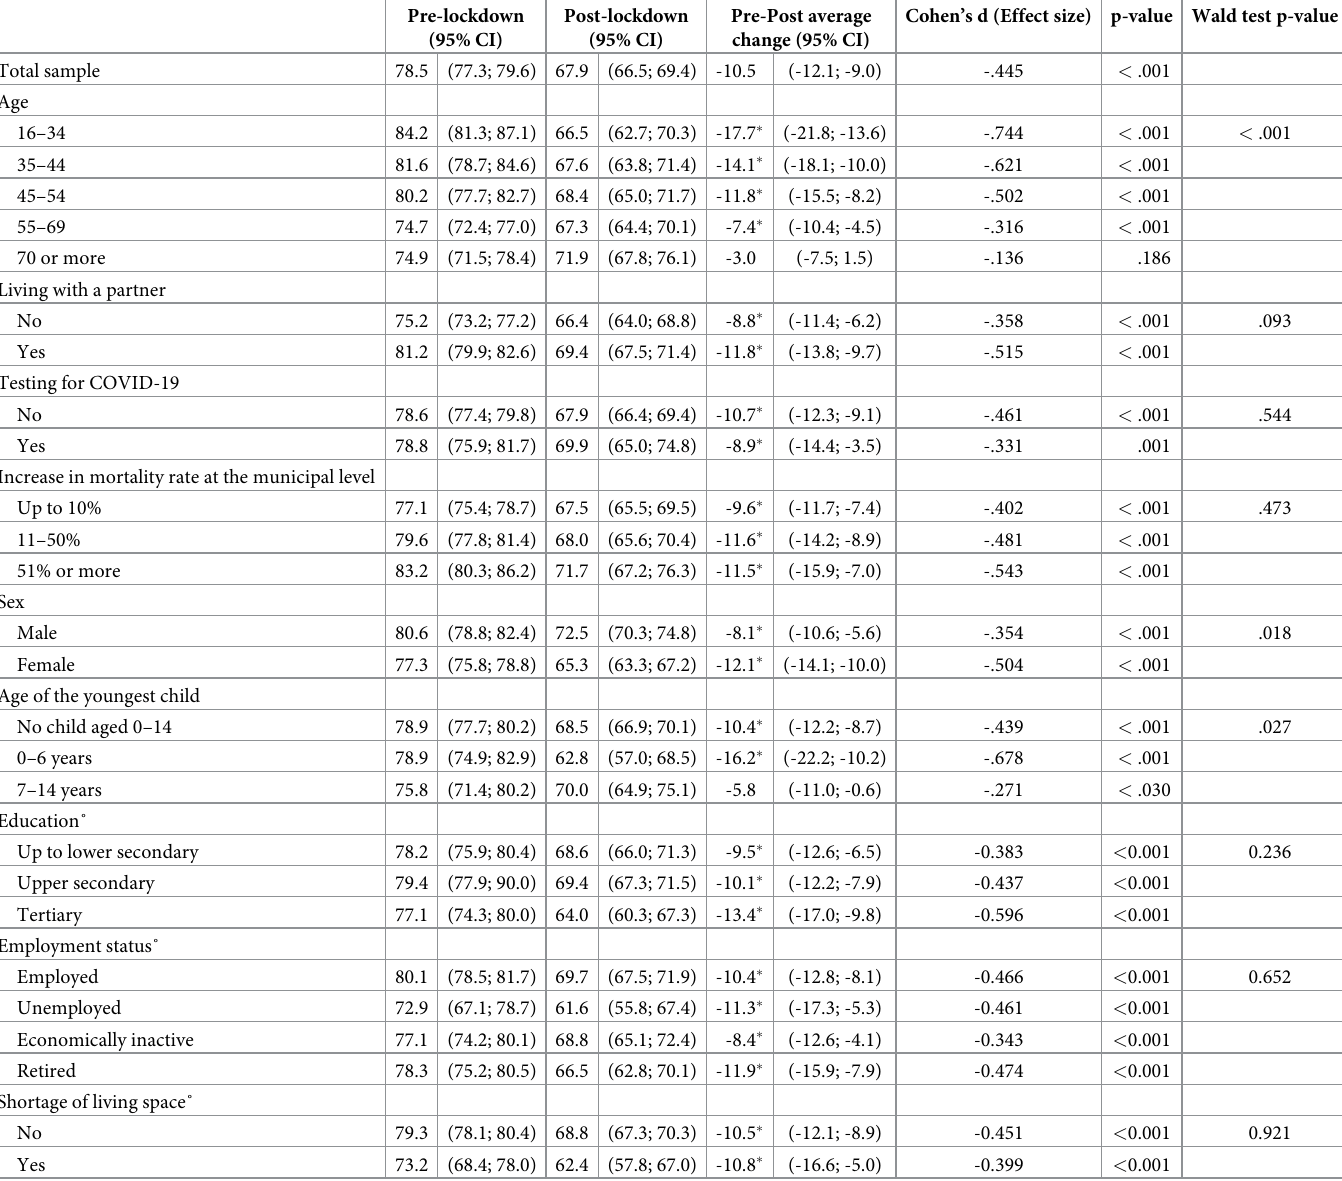
Table 3. Random-effects regression analysis showing the change in mental health scores associated with the implementation of COVID-19 lockdown